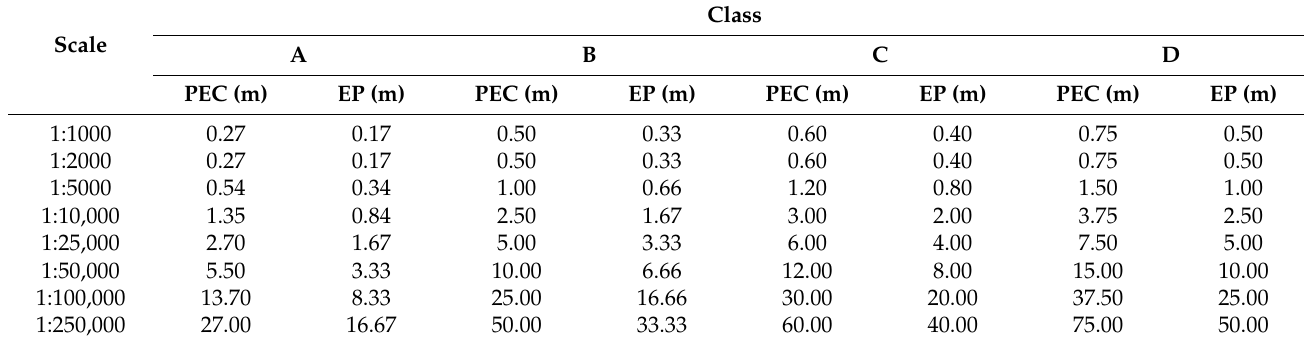
Table 1. Standard of altimetric cartographic accuracy of digital elevation models (DEMs) for the production of digital cartographic products defined for eight different scales and for classes A (most restricted), B, C, and D (least restricted).